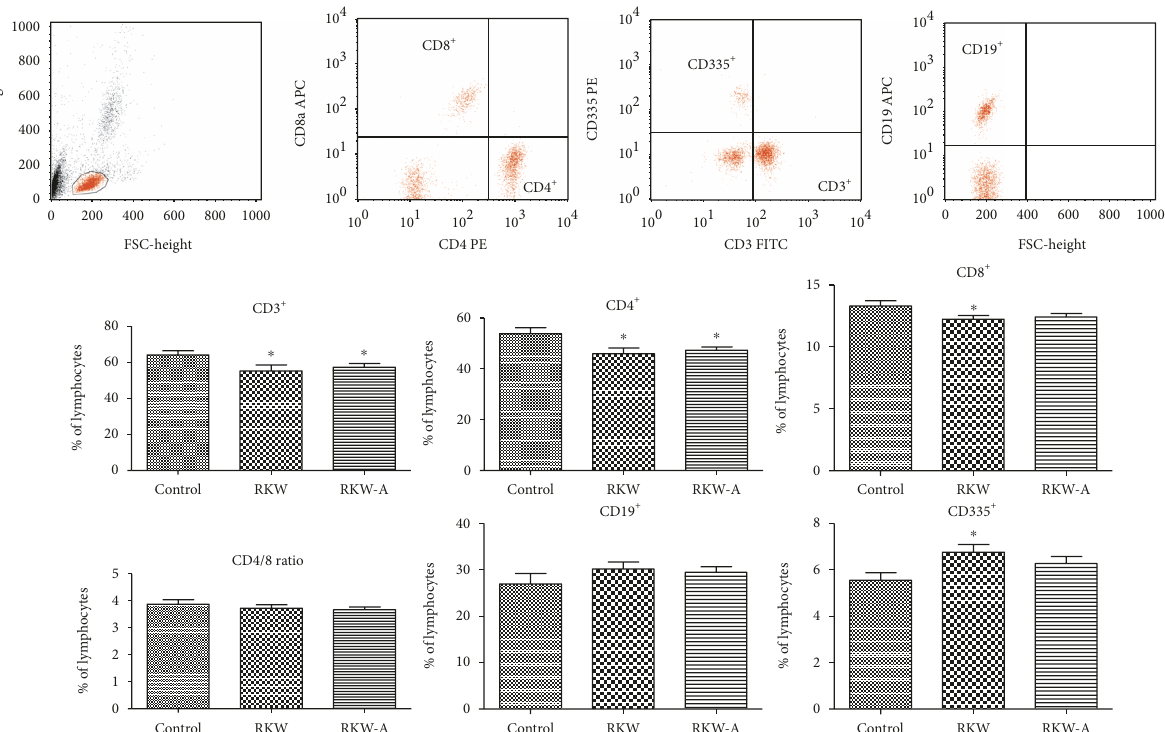
Figure 1: Blood lymphocyte phenotype analysis (mean % ± SEM). Analysis was performed in the o ff spring of mothers fed during pregnancy and lactation with water (RKW) or hydroalcoholic (RKW-A) extract of Rhodiola kirilowii . ∗ P < 0 05 .